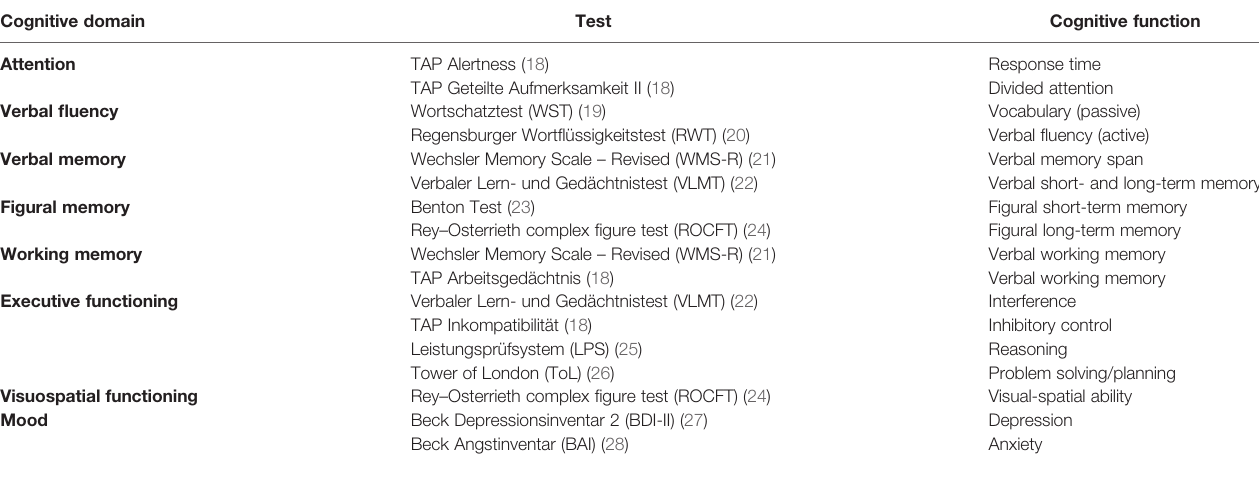
TABLE 1 | Neurocognitive assessment, tasks per neurocognitive domain. Cognitive domain